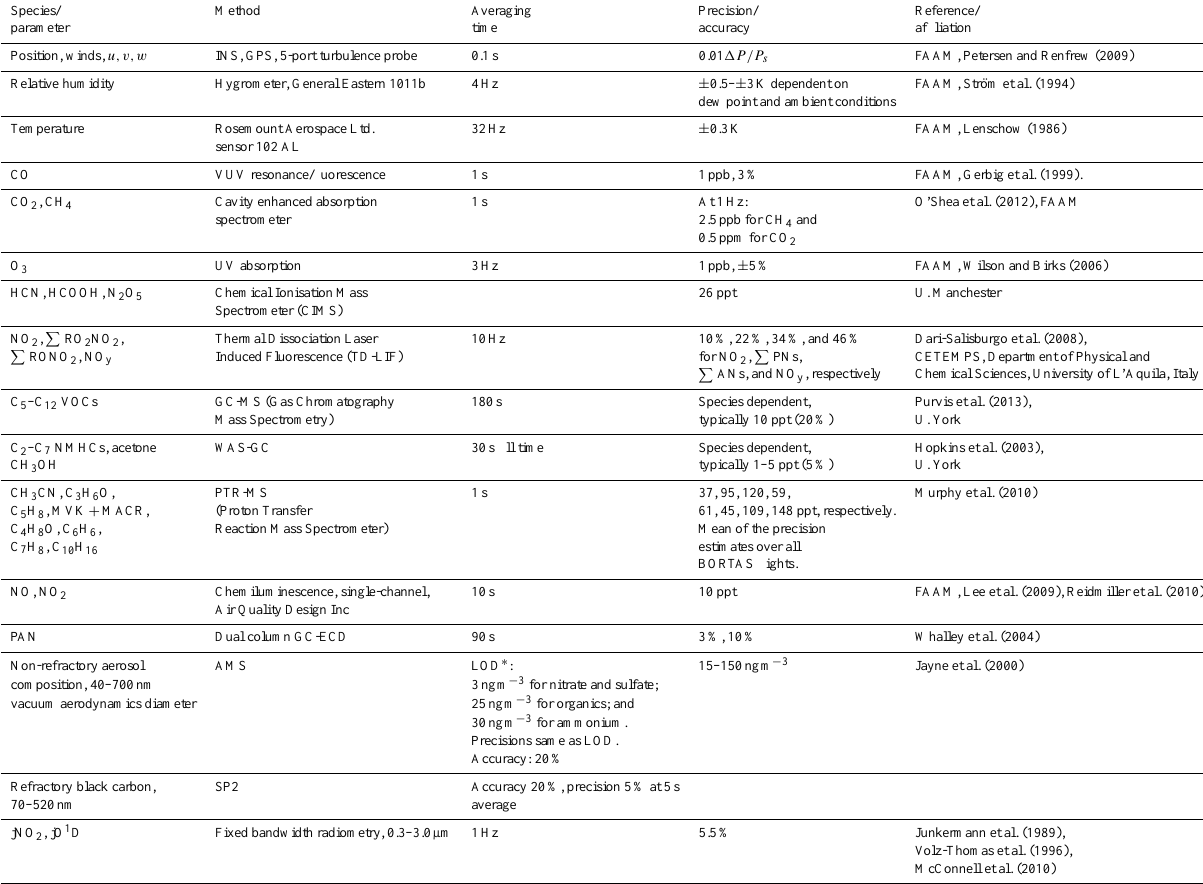
Table 2. BAe-146 payload during BORTAS.